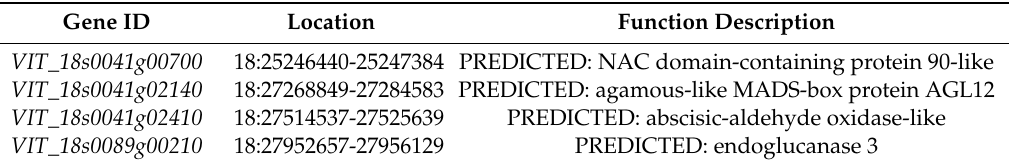
Table 6. Candidate genes screened from the QTL regions.